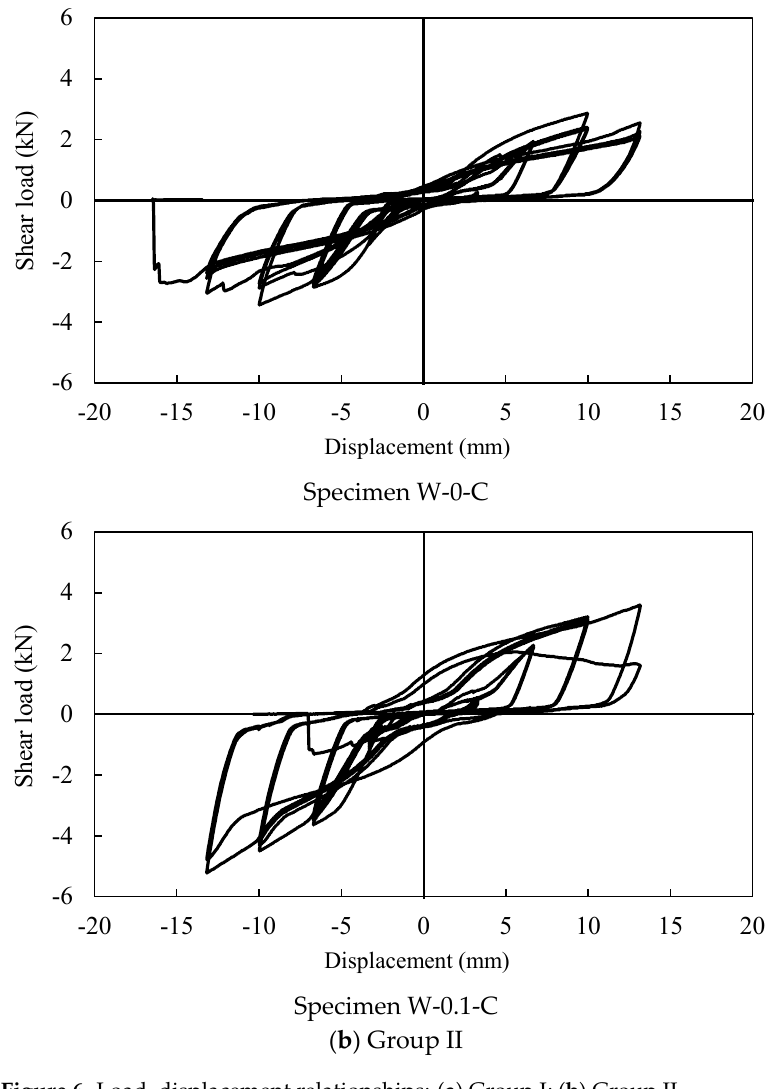
Figure 6. Load–displacement relationships: ( a ) Group I; ( b ) Group II.